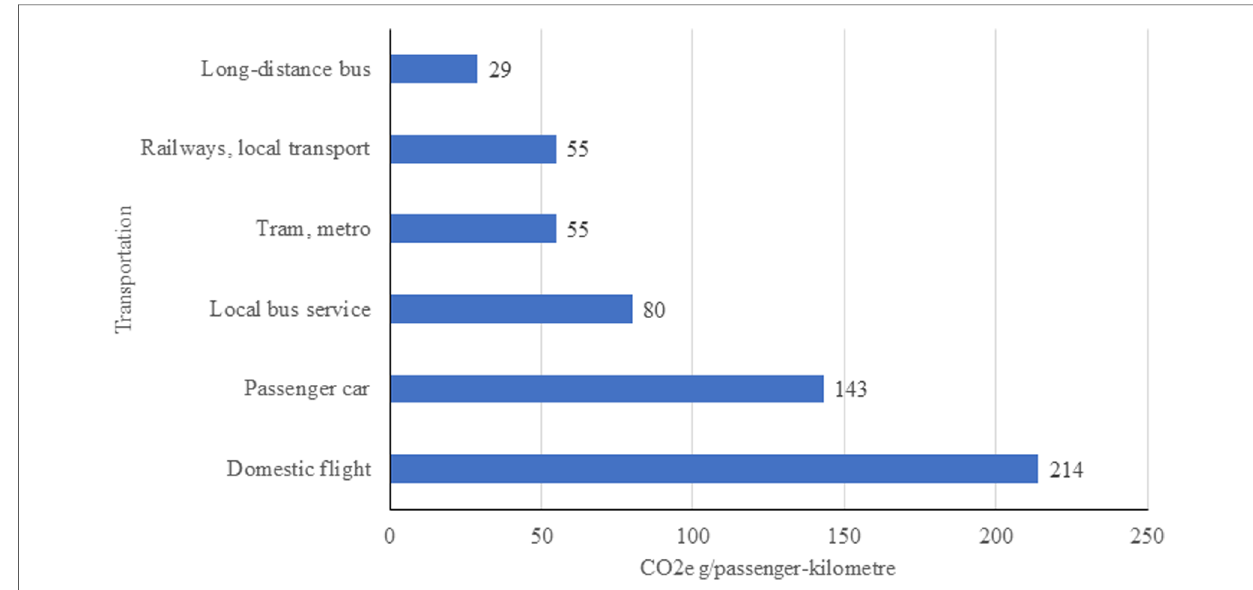
FIGURE 1 Co 2 e emission of transportation compiled after the German federal environment agency (6).